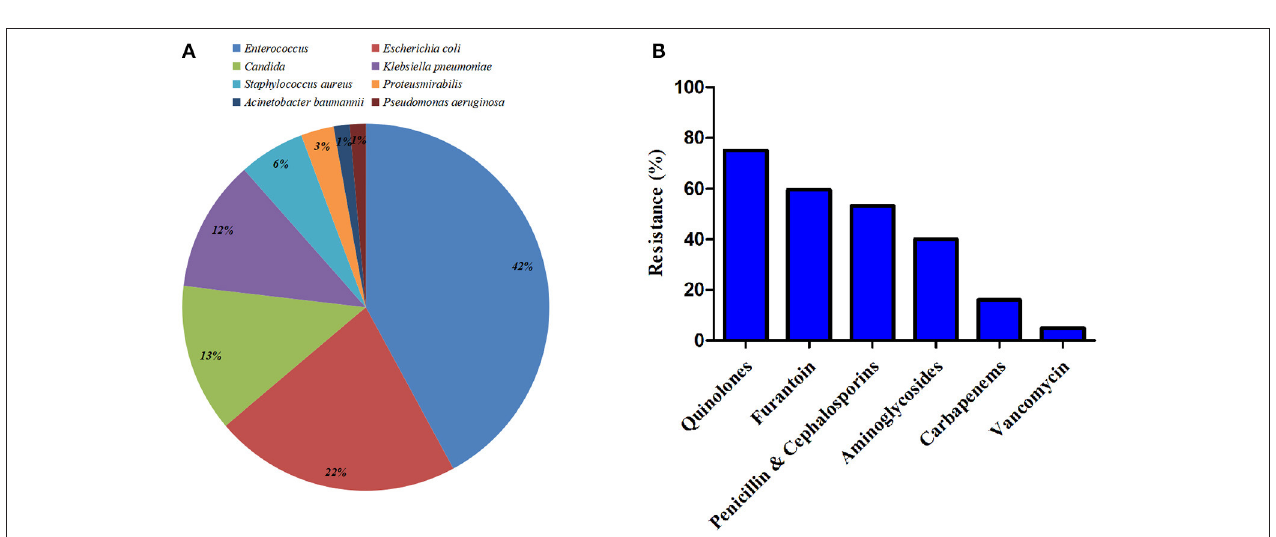
FIGURE 2 | Microbiology of urinary tract infection (UTI) within 90 days after radical cystectomy (RC) and urinary diversion. (A) Identified pathogens among patients in the study. (B) Antibiotic resistance of the identified